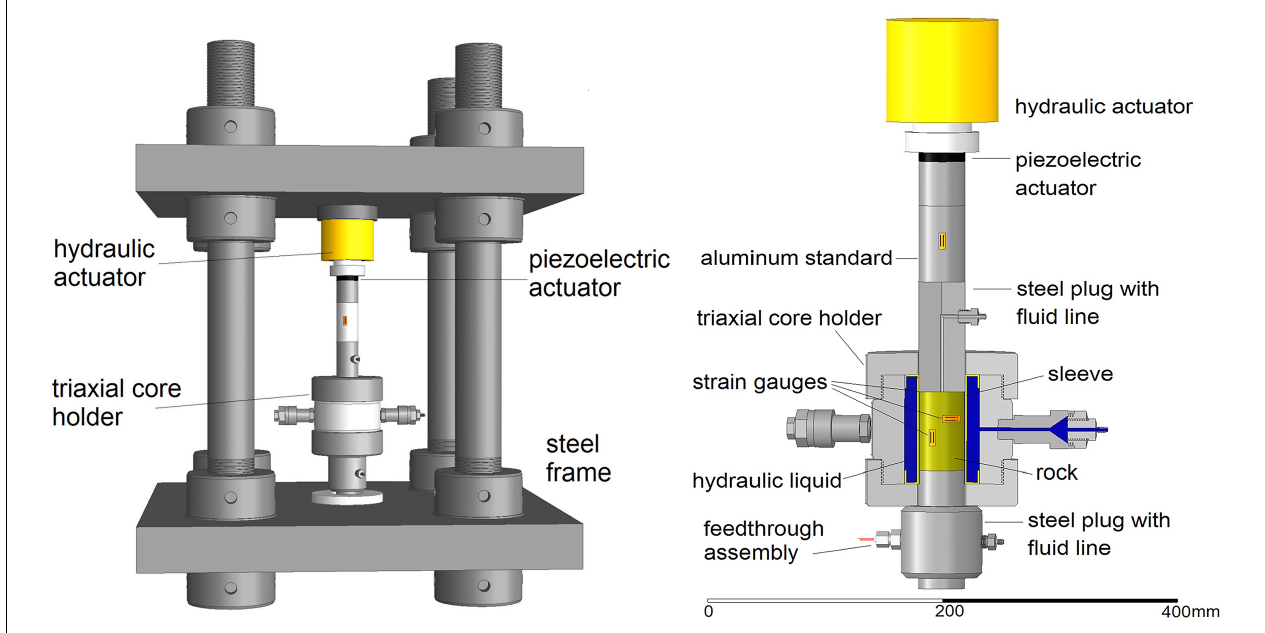
FIGURE 1 | The seismic frequency laboratory